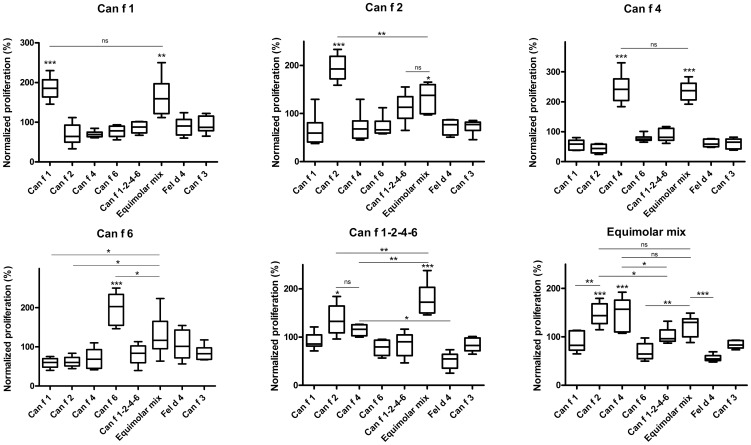
Splenocyte proliferation assay in immunized mice.Proliferative responses after stimulation of splenocytes from immunized mice (immunization allergen denoted as individual graph heading), stimulated with equimolar amounts of rCan f 1, rCan f 2, rCan f 4, rCan f 6, an equimolar mix or Can f 1-2-4-6 (x-axis) and measured by [3H] thymidine incorporation (y-axis). Boxes with median values and horizontal bars denote 50% of values and 1 standard deviation respectively. * p<0.05, ** p<0.01, *** p<0.001 and ns (non significant) p>0.05, analyzed with repeated measurements ANOVA with Tukey's multiple comparison test